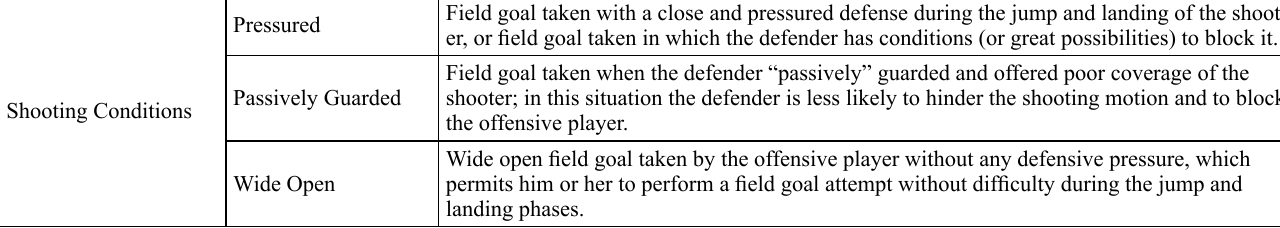
Shooting Efficacy